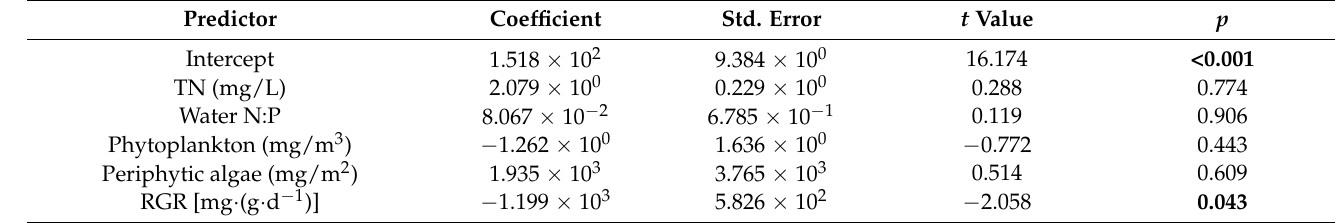
Bold numbers indicate significant differences ( p <